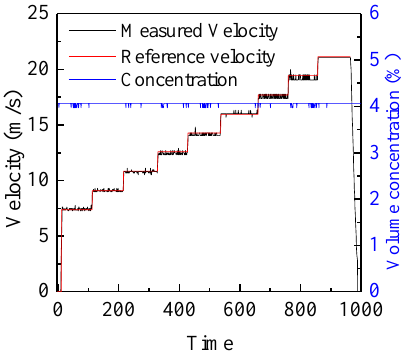
Figure 8. Continuous measurement results of velocity and concentration.